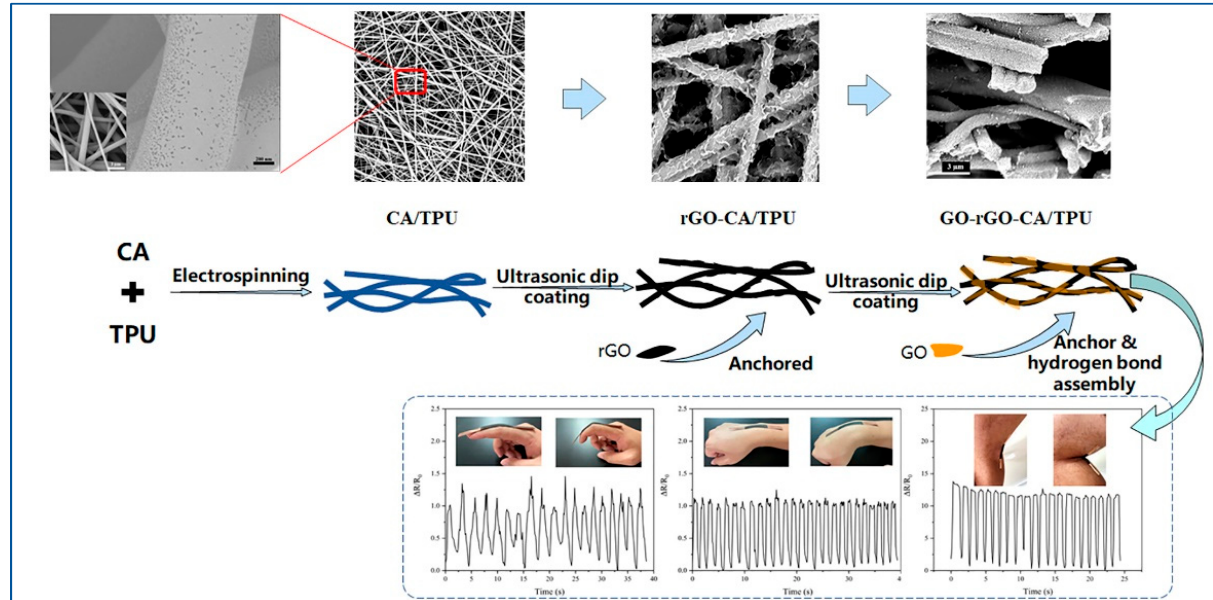
Figure 1. Schematic diagram of the whole preparation process of the GO/rGO@CA/TPU nanofiber film.